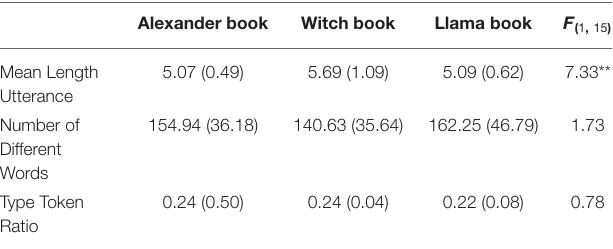
TABLE 2 | Summary of parents’ language measures (mean and standard deviation) in the storytelling tasks in